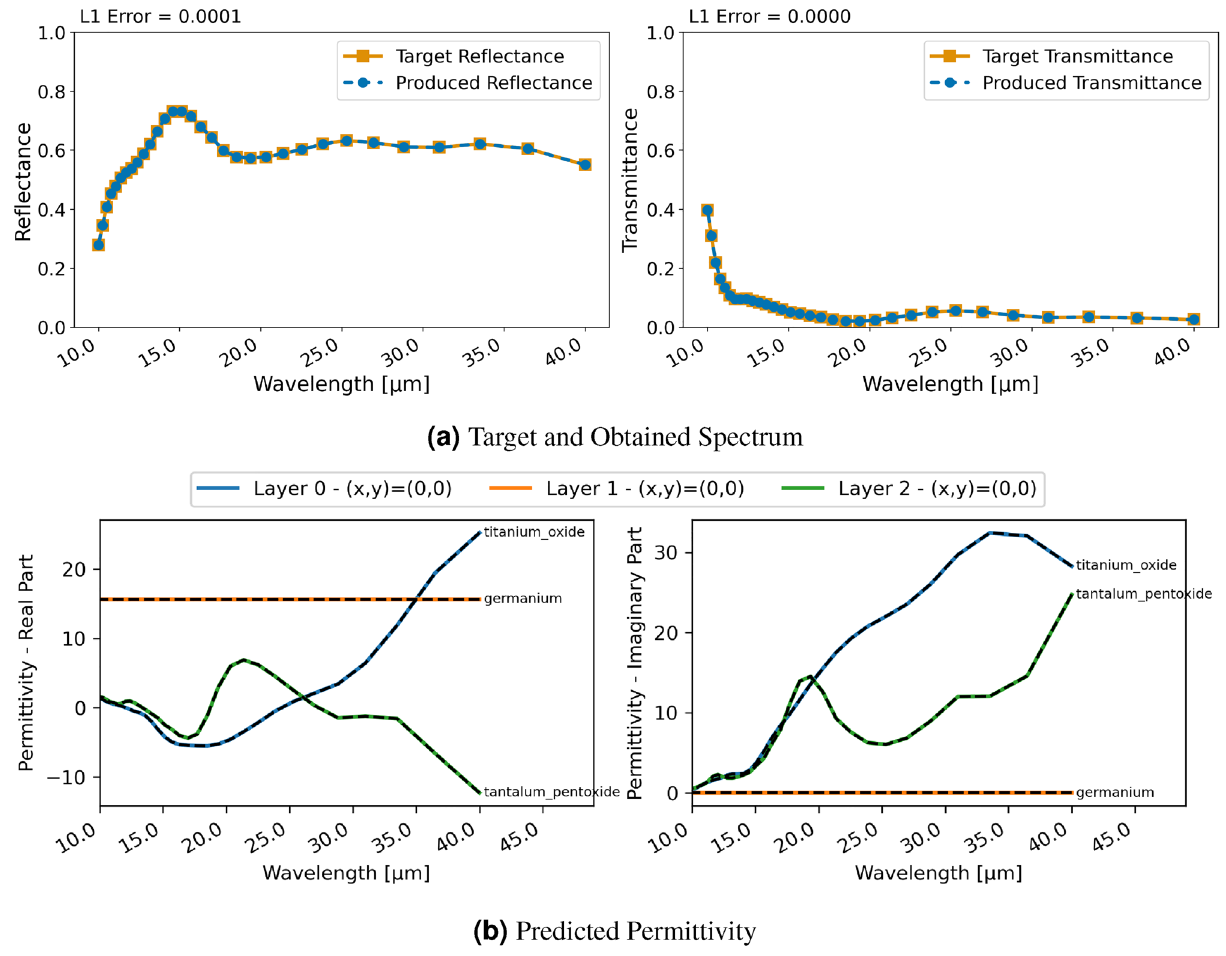
Figure 6. Inversion results for a three-layer material using RCWA and classification; ( a ) displays target and produced spectra, ( b ) shows the utilized permittivity for each